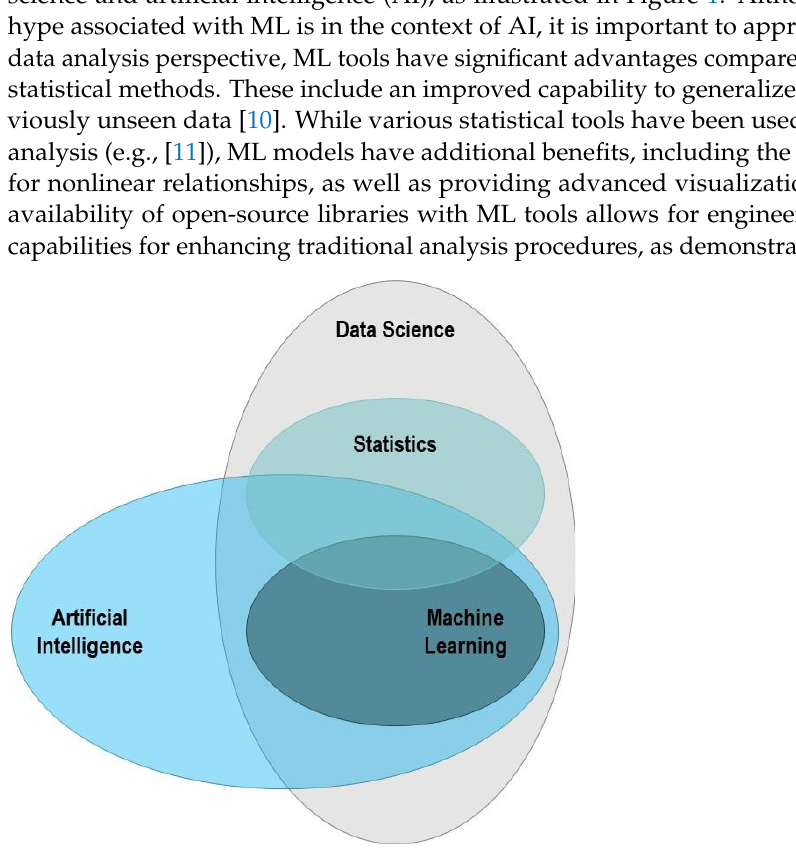
Figure 1. Venn diagram of the relationship between ML and the broader fields of AI and data sci-